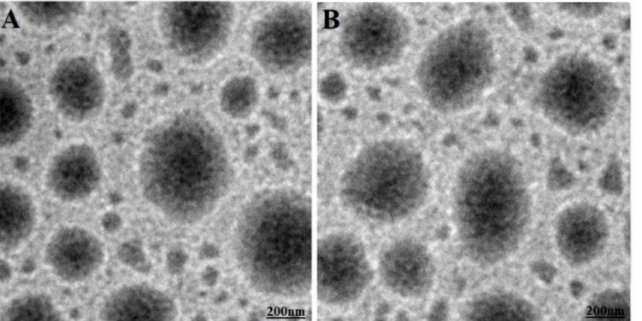
Figure 3. ( A ) Transmission electron microscopy (TEM) image of the dispersed o/w type of NF5 in water after 30 min, and ( B ) TEM of dispersed NF5 (o/w) in the drug solution after 30 min. Both exhibited globular sizes below 100 nm at 15,000 × (magnification). Table 2. Kinetically stable nanoemulsions (water/DMSOT/IPA/CMC8).